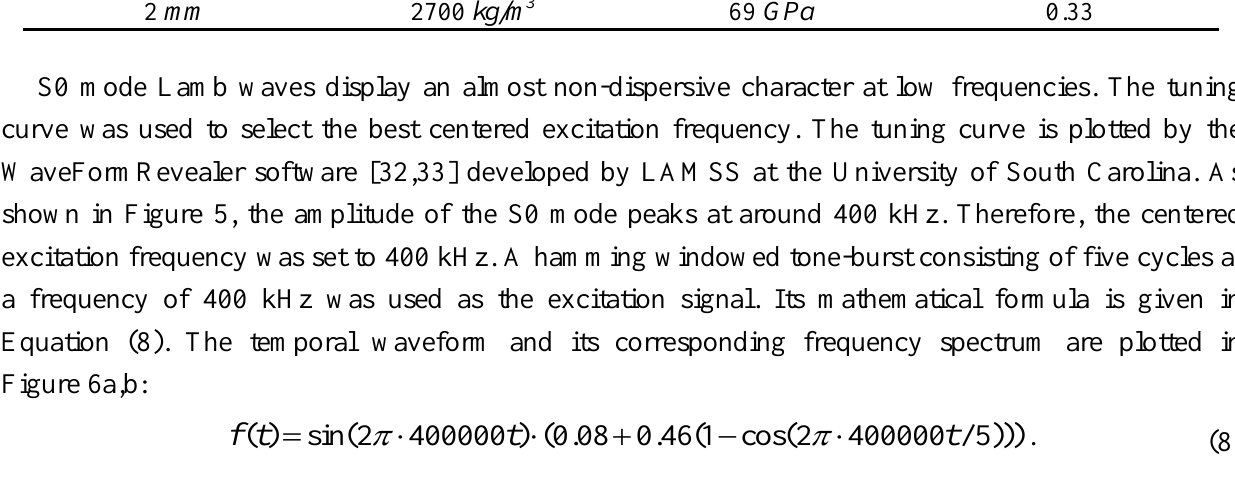
Figure 5. Tuning curve showing that the amplitude of the S0 mode reaches its peak at around 400